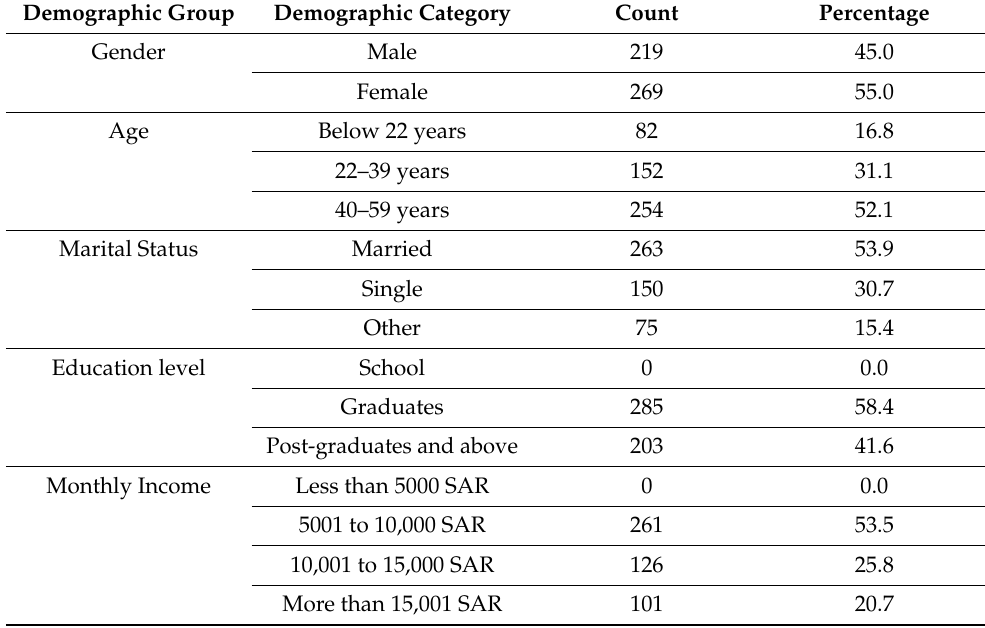
Table 2. Demographic profile of